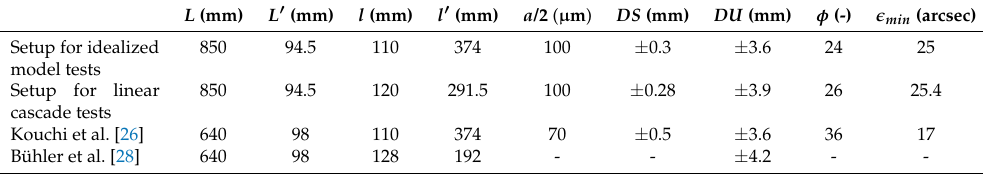
Table 1. Specification of focusing schlieren system and comparison with systems from the